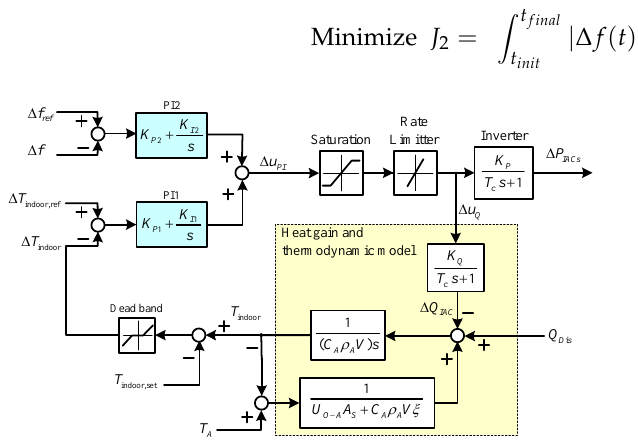
Figure 10. PI controllers for IACs control.